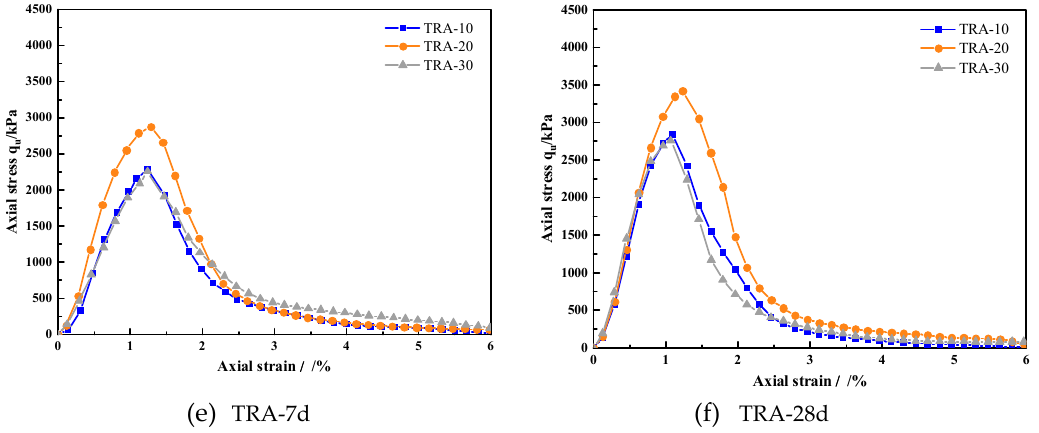
Figure 4. Stress–strain relationship curve of samples with different particle grading recycled aggregate contents: ( a ) RA-7d; ( b ) RA-28d; ( c ) SRA-7d; ( d ) SRA-28d; ( e ) TRA-7d; ( f ) TRA-28d.